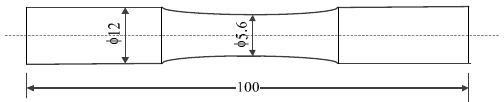
Figure 12. The dimensions of the AZ31 magnesium alloy specimen.